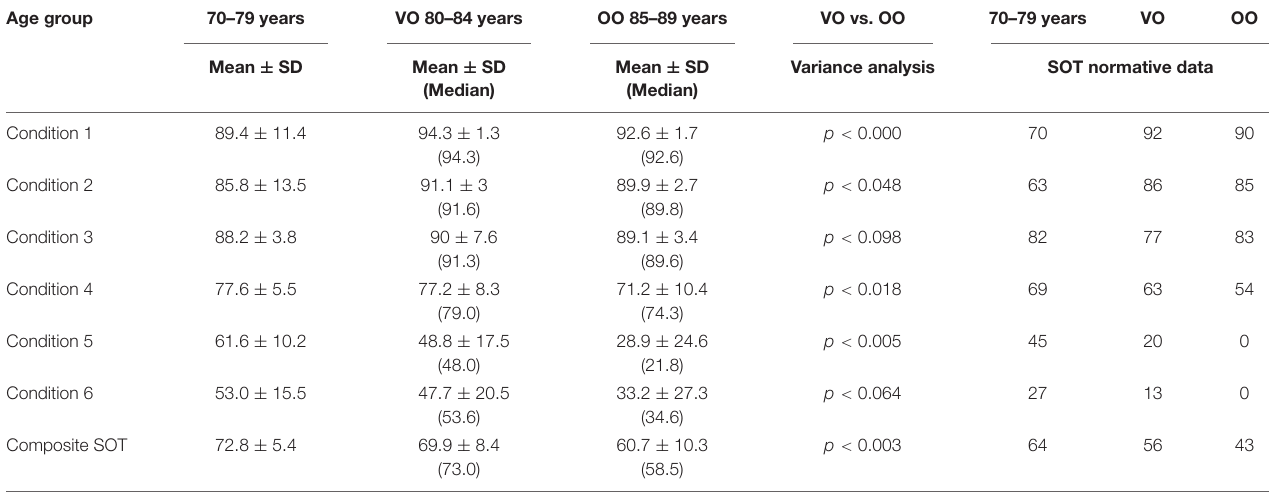
FIGURE 2 | Mean values for the three age groups in the six conditions and for the composite Sensory Organization Test data. The lowest values in condition 5 describe an age-related worsening of vestibular function. Data for the 70–79 age group are provided by NeuroCom R (cid:13) International Inc. (2003). TABLE 3 | Descriptive, variance analysis, and normative data for each condition and composite SOT for three age groups: 70–79 years (data provided by NeuroCom R (cid:13) International Inc., 2003), very old (VO, 80–84 years), and oldest old (OO, 85–89